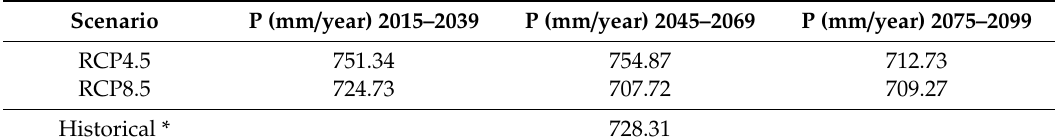
Table 4. Projections of P based on RCP4.5 and RCP8.5 scenarios using the GFDL-CM3 global circulation model.